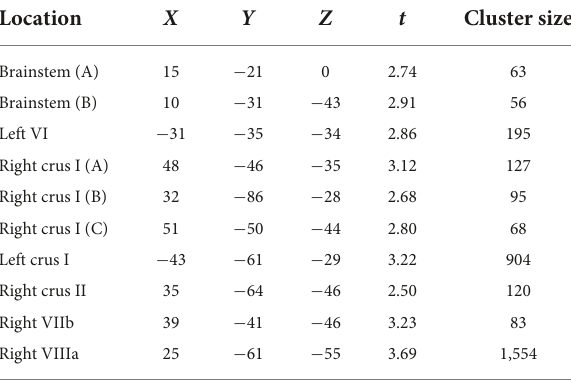
TABLE 2 Montreal Neurological Institute (MNI) coordinates for significant grey matter volume reductions in children with developmental coordination disorder compared to typically-developing